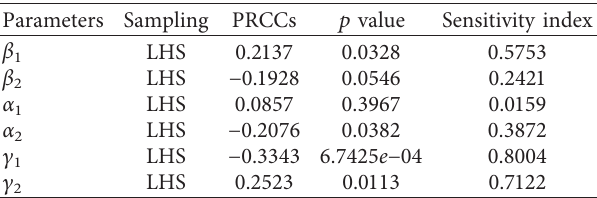
Table 7: PRCCs for R A 0 and six input parameters and the cor- responding sensitivity